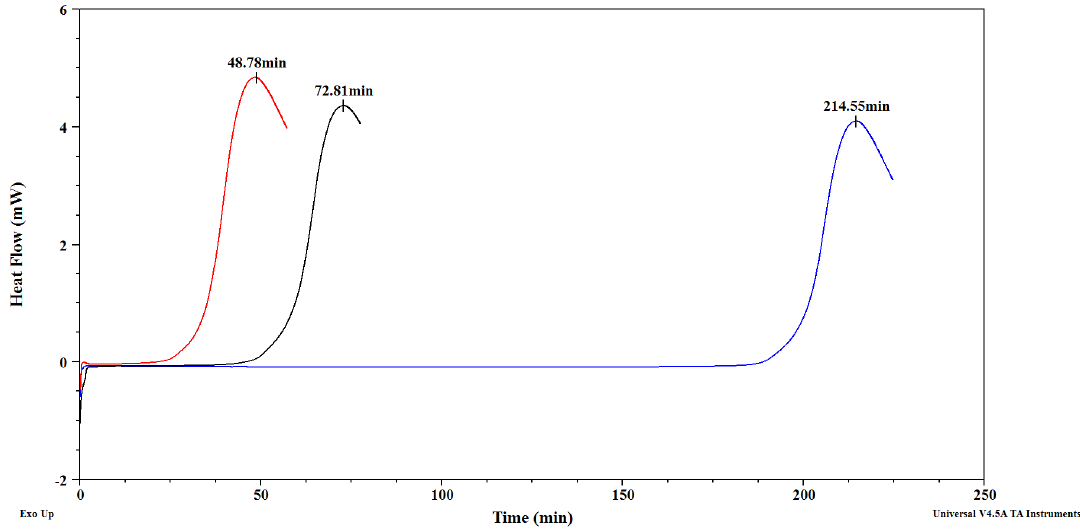
Figure 3. Exemplary pDSC curves of oxidation induction time for cranberry (blue), black currant (black) and strawberry (red) seed oils at 100 °C.